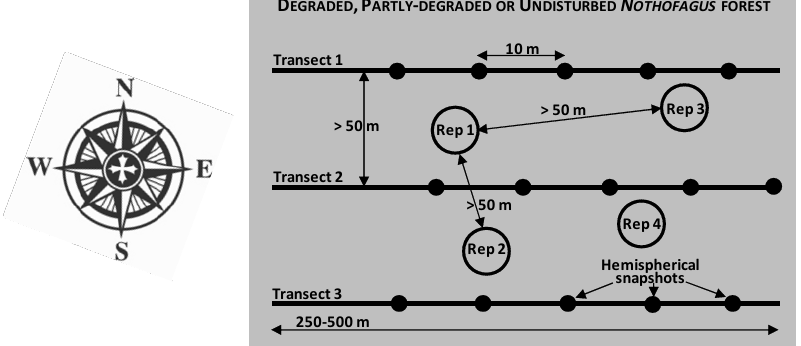
Figure 2. General layout of the treatments (DEF: Degraded, PDF: partly ‐ degraded, UNF: undisturbed Nothofagus forests), sampling design and experimental 500 ‐ m 2 plots (four replicates) established within every set of three parallel transects in the Andean and Coastal mountains of south central Chile. Table 1. Baseline information about the two study sites in the Andean and Coastal mountains of south central Chile: Condition (DEF: Degraded, PDF: partly ‐ degraded, UNF: undisturbed forests), principal and accompanying species, and stand density (stems ∙ ha − 1 ), range of diameters (cm), mean diameter at breast height ‐ DBH (cm), basal area (m 2 ∙ ha − 1 ), and mean total height ‐ HT (m) of Nothofagus obliqua trees.